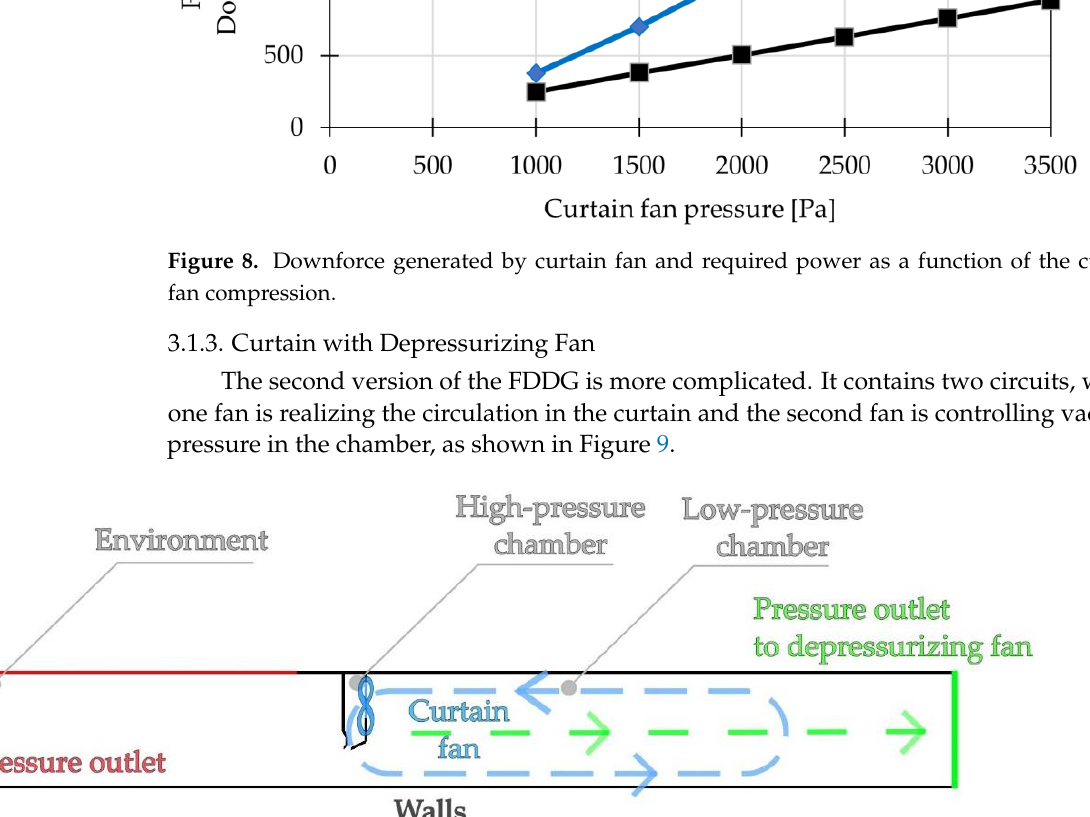
Figure 10. Velocity and pressure contours for the FDDG with air curtain and depressurizing fan, with curtain fan Δ p = 3000 Pa and pressure at the outlet to depressurizing fan p = −1000 Pa. Similar downforces may exist for two different parameter settings for the recircula- tion fan and the depressurizing fan. Figure 11 presents the basic characteristics of this